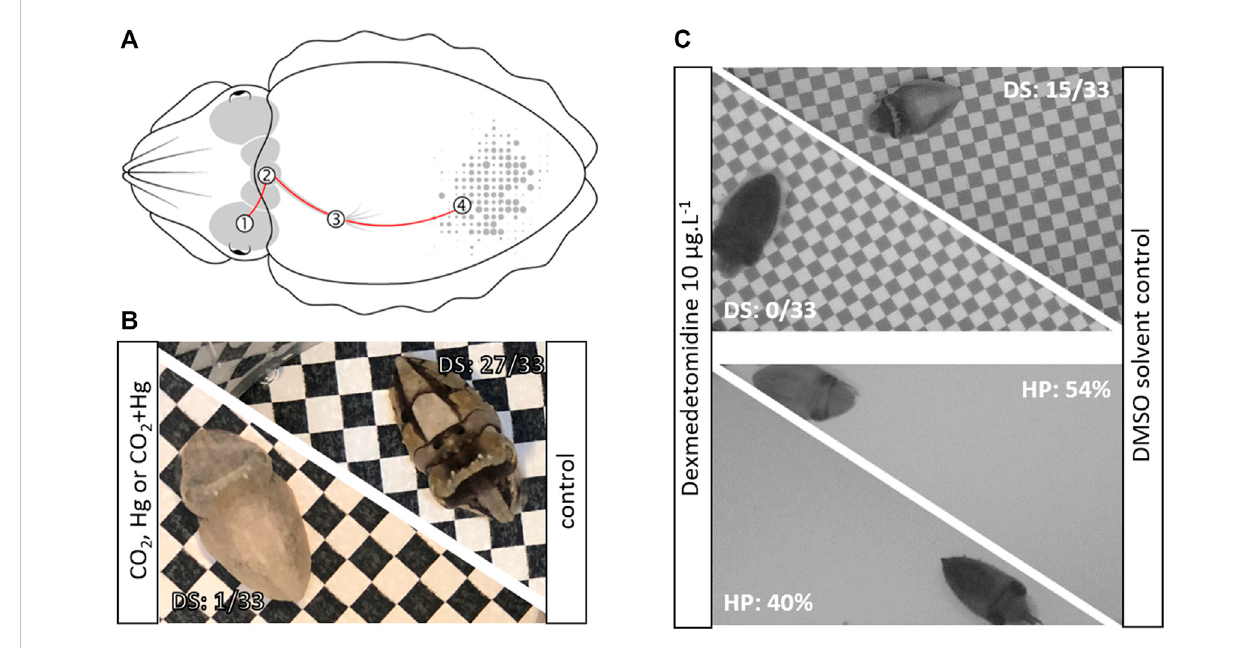
FIGURE 1 (A) . Diagram of the neuronal control of chromatophores in the European cuttle fi sh: The visual information is transmitted from the eye (1) to the central nervous system (through the optic lobes, the lateral basal lobes, then the chromatophore lobes) that controls the motor activity of chromatophores (4) through the stellate ganglion (3), (B) . Example of cuttle fi sh hatchlings exposed for 1 month to CO 2 (i.e., pH 7.54), Hg (i.e., 3 μ gg -1 dry weight in muscle) or CO 2 +Hg, with a low disruptive score (left) compared to a cuttle fi sh from control conditions (i.e., pH 8.02; right) with a high disruptive score, (C) . Example of cuttle fi sh hatchlings exposed for 3 days to dexmedetomidine during 3 days displaying a dark uniform pattern on both checkerboard and uniform backgrounds compared to cuttle fi sh from solvent control conditions (DMSO: dimethyl sulfoxide; DS: disruptive score; HP: homochromy